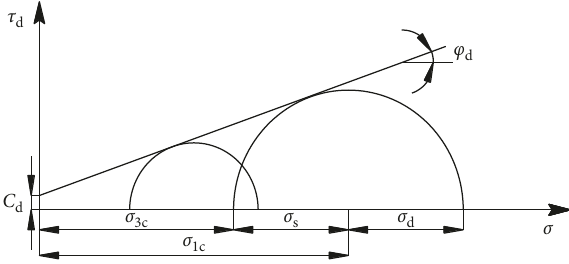
Figure 4: Schematic diagram of Mohr’s circle and strength en- velope under initial shear stress conditions.